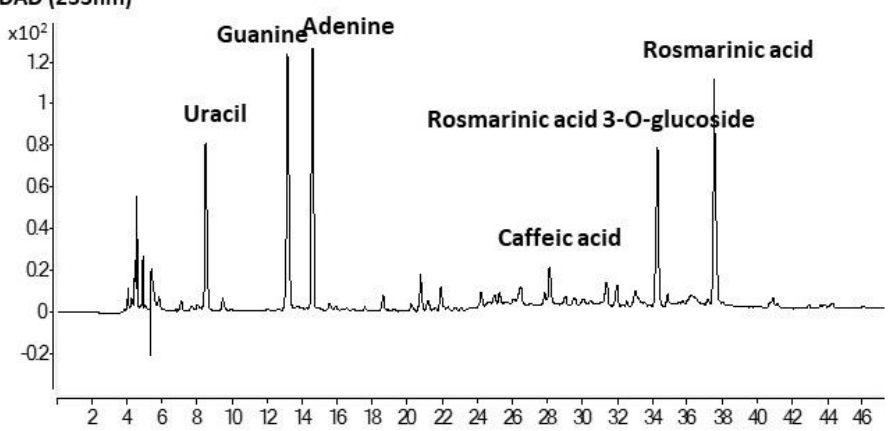
Figure 4. HPLC profile of ethanol/water extract of de-oiled cake of chia